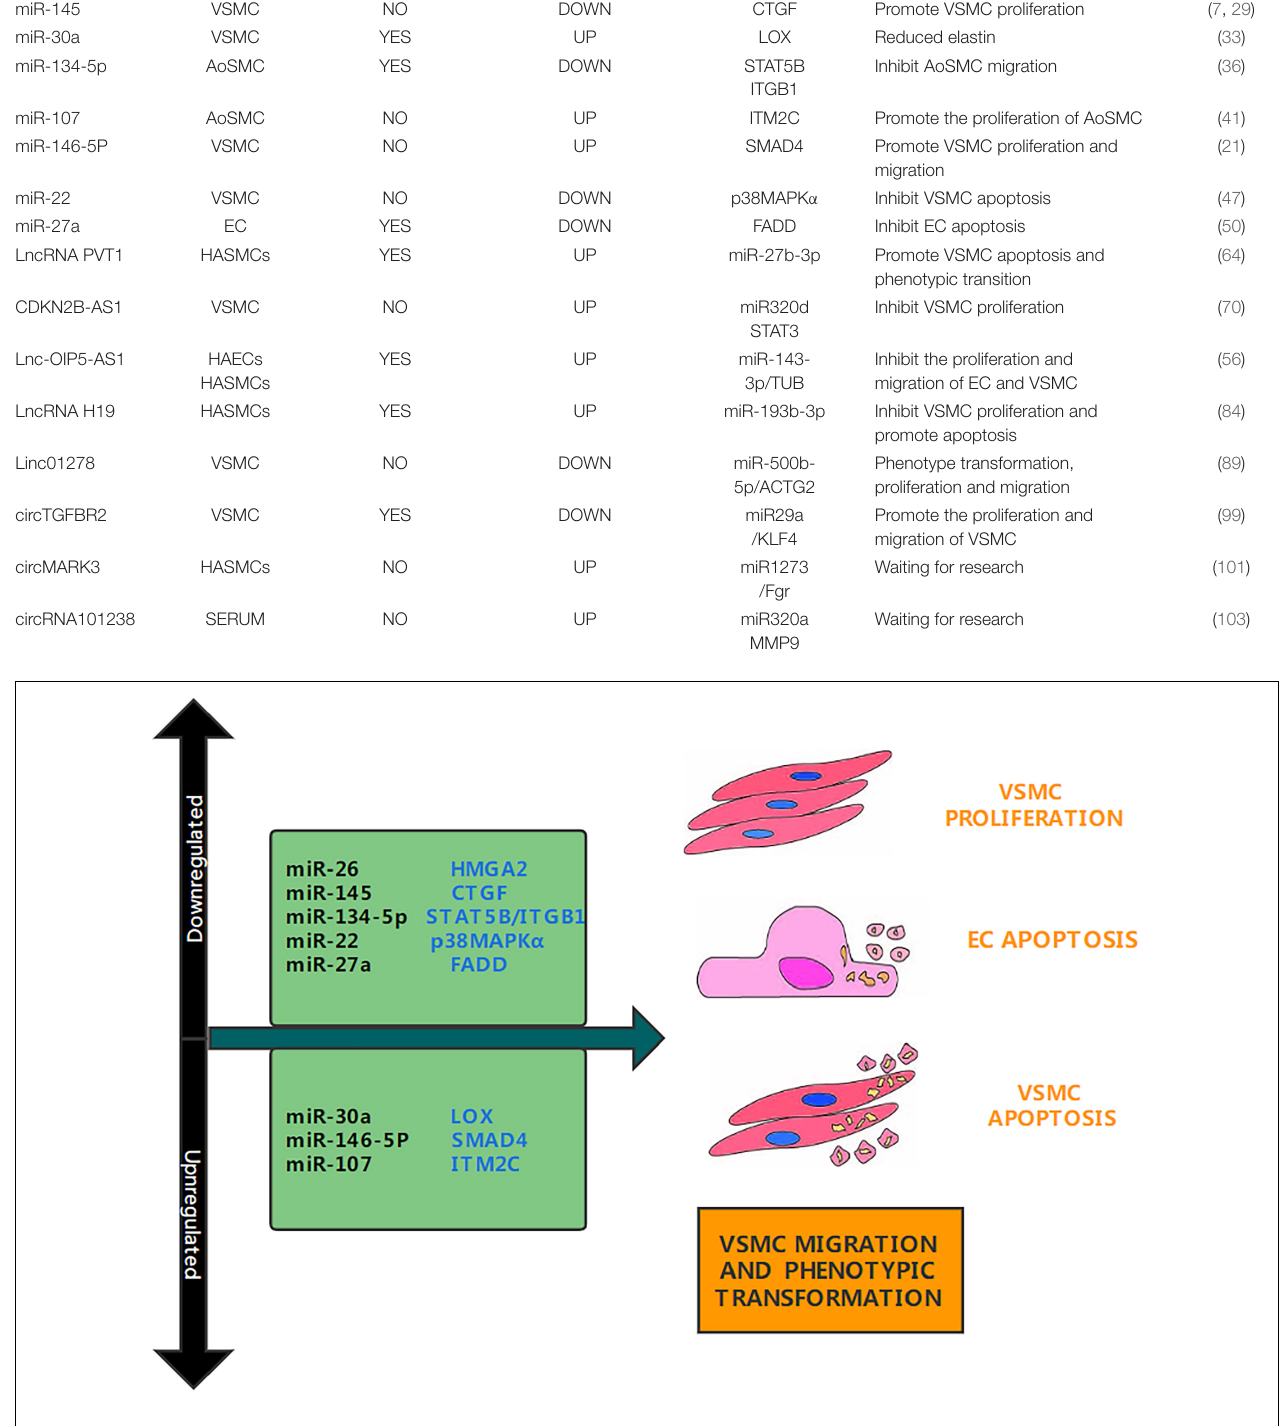
FIGURE 1 | Aortic dissection associated miRNAs. Several studies have determined that miRNAs are upregulated or downregulated in aortic dissection. This figure shows the miRNAs involved in the pathogenesis of aortic dissection and their target genes, as well as their functions.